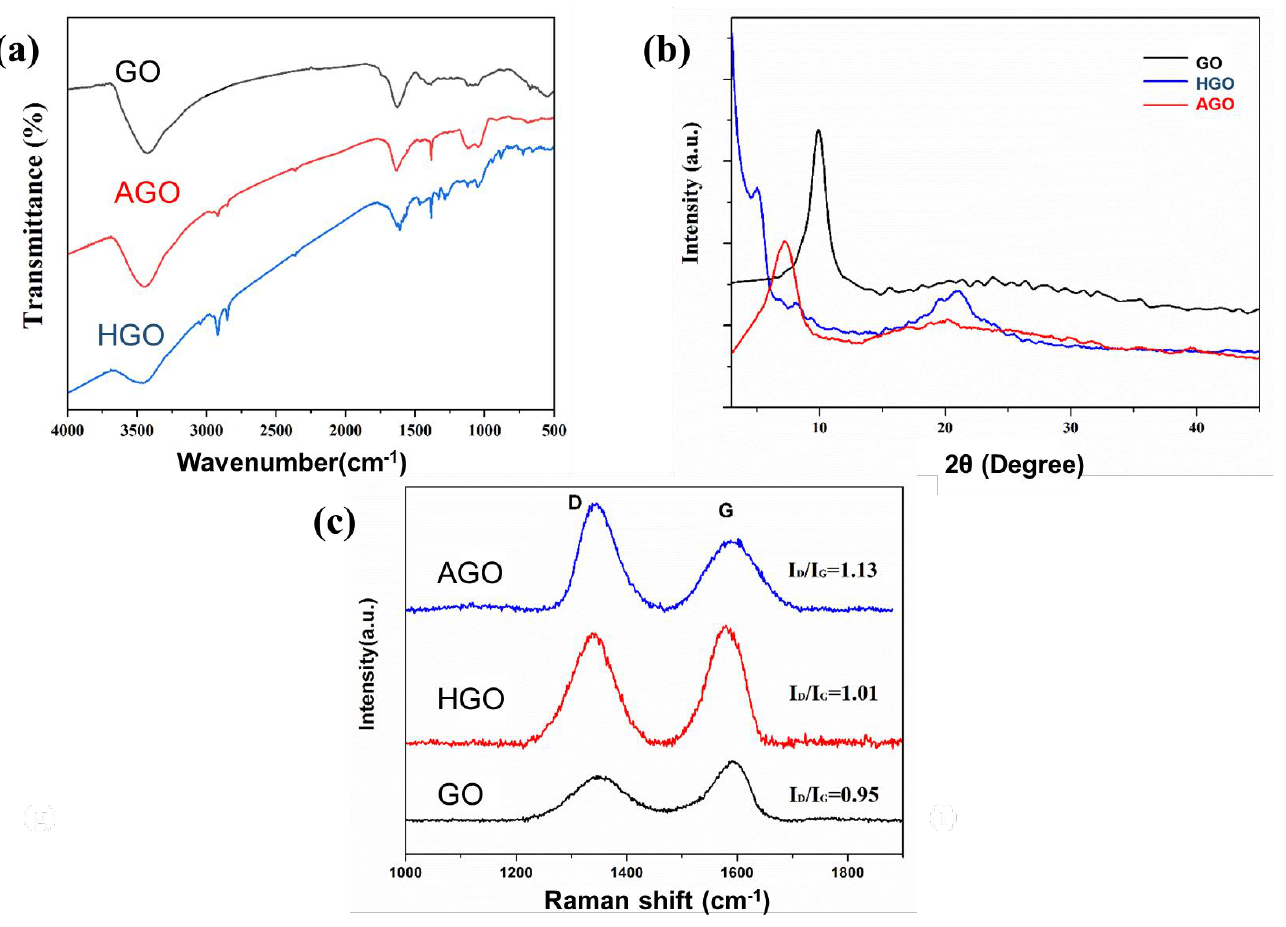
Figure 2. FTIR spectrum ( a ), Raman spectrum ( b ), and XRD patterns ( c ) of GO, AGO, and HGO. Through the XRD spectrum, the interlayer spacing and crystal structure can be ob- tained. Figure 2b is the XRD pattern of GO, AGO, and HGO. The XRD curve of GO showed a strong (002) characteristic diffraction peak at 10.1 ◦ , the spacing between GO sheets was calculated to be 0.83 nm using Bragg’s law. As for AGO, the intensity of